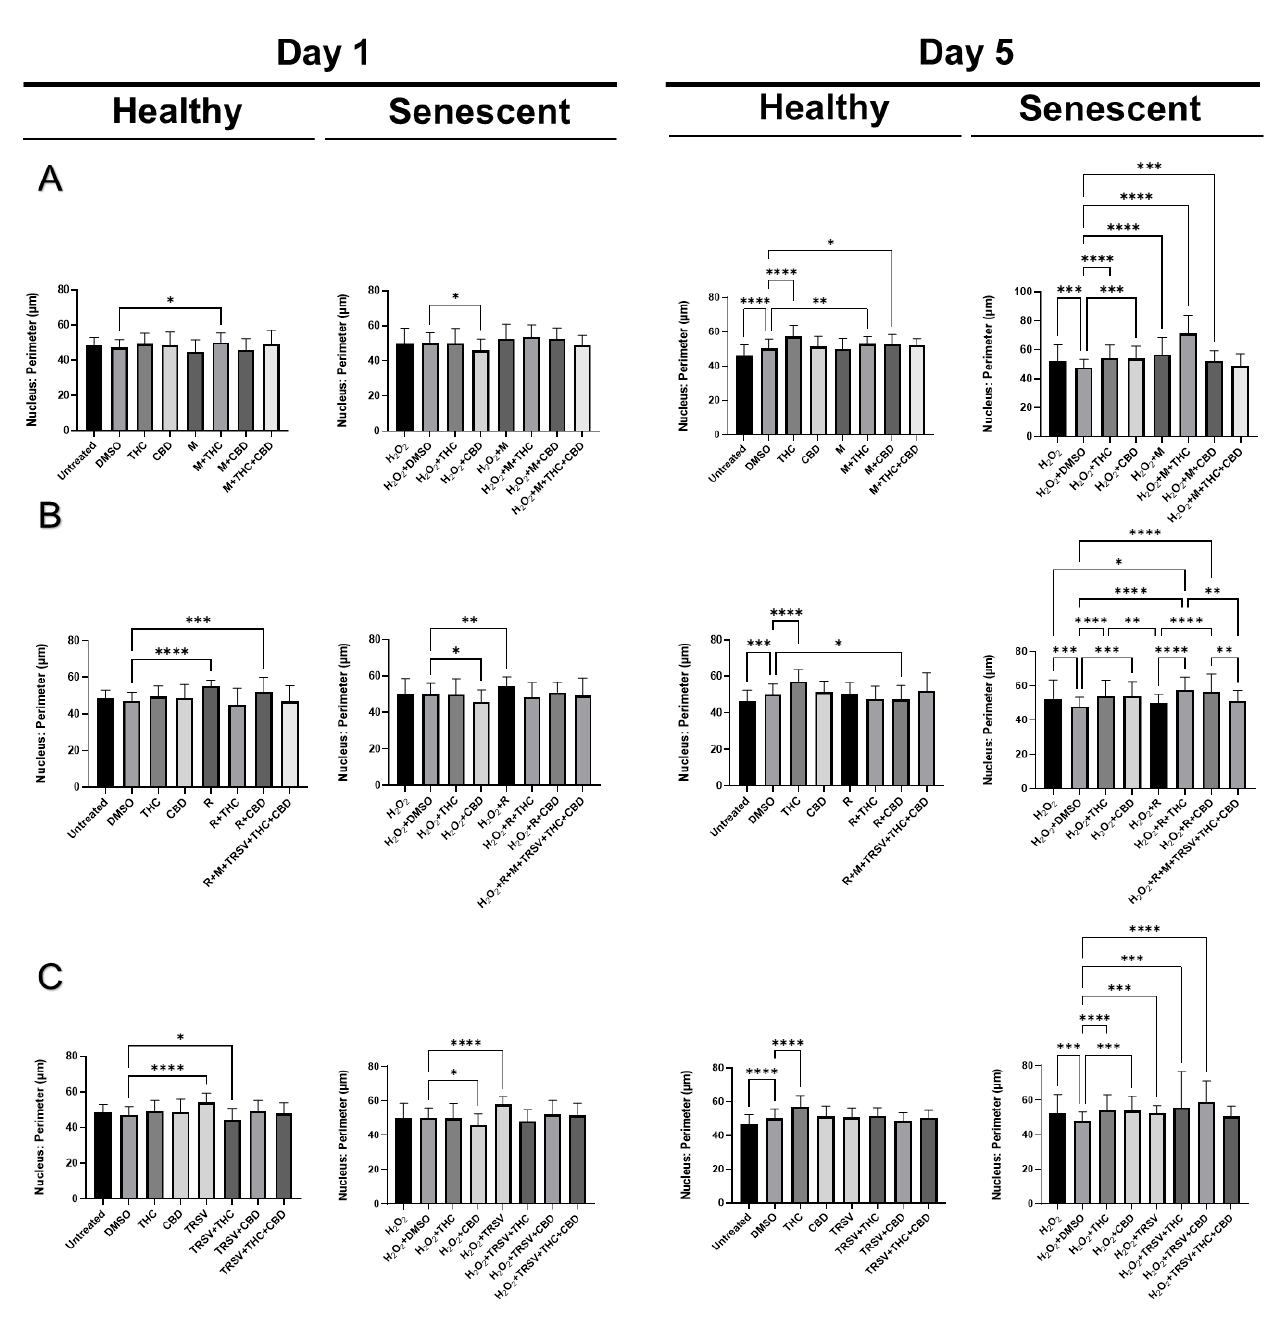
Figure 9. DAPI-stained nuclei perimeter parameters of skin fibroblasts CCD-1064Sk (p.11) exposed to metformin, triacetylresveratrol, and rapamycin combined with pCBs. Nuclear parameters were observed by immunofluorescence microscopy for: healthy and senescent fibroblasts treated with ( A ) 500 μM metformin, ( B ) 5 μM rapamycin, or ( C ) 10 μM triacetylresveratrol and combinations with pCBs compared to 2 μM of THC, 2 μM of CBD, DMSO, and untreated fibroblasts after 1 day and 5 days of exposure. Data were analyzed with a one-way ANOVA test followed by a Dunnett’s post hoc test compared to the DMSO or H 2 O 2 + DMSO control. Bars represent mean ± SD. Significance is indicated within the figures using the following scale: * p < 0.05, ** p < 0.01, *** p < 0.001, **** p < 0.0001. CBD, cannabidiol; DMSO, dimethyl sulfoxide (vehicle), M, metformin; R, rapamycin; THC, Δ -9-tetrahydrocannabinol; TRSV, triacetylresveratrol.